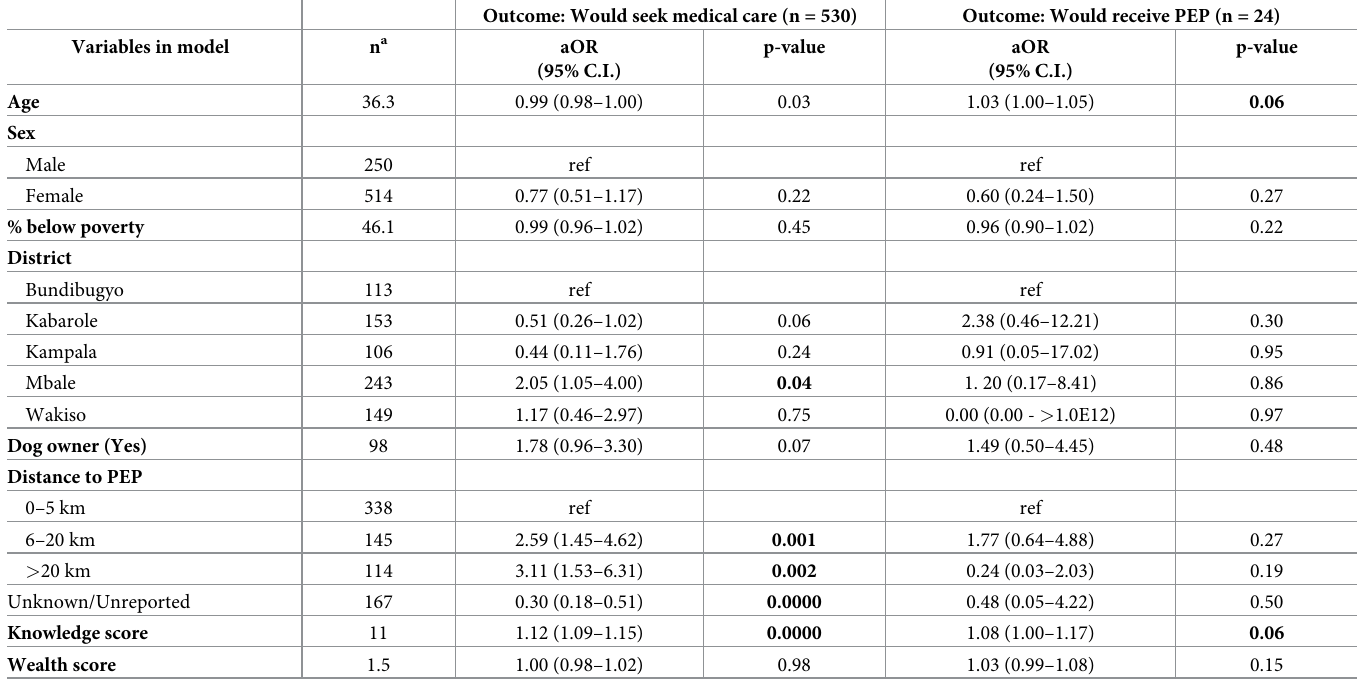
Table 5. Characteristics associated with attitudes concerning healthcare-seeking behaviors among 764 not bitten respondents, Uganda, 2013. Outcome: Would seek medical care (n =